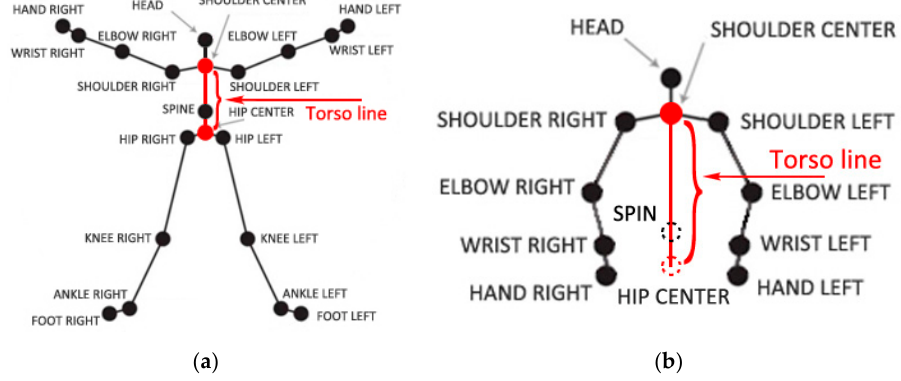
Figure 1. Joints of a person’s skeleton provided by Kinect. ( a ) Twenty joints of the skeleton that can be tracked when the person is standing; ( b ) 10 joints and two estimated joints of the skeleton when the person is sitting, where spin and hip center joints marked with two circles of dotted lines are estimated.